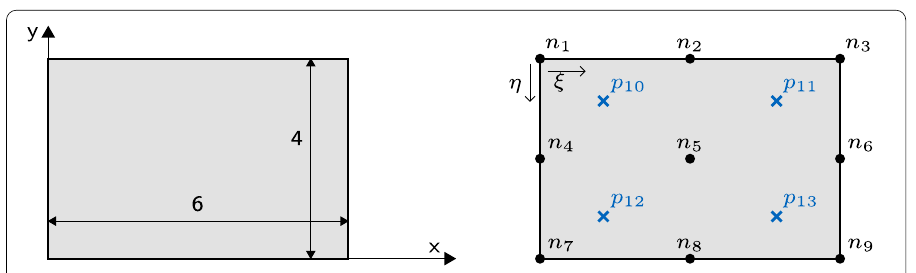
Fig. 21 Example single patch: the patch has 9 control points (black points) and 4 quadrature points (blue